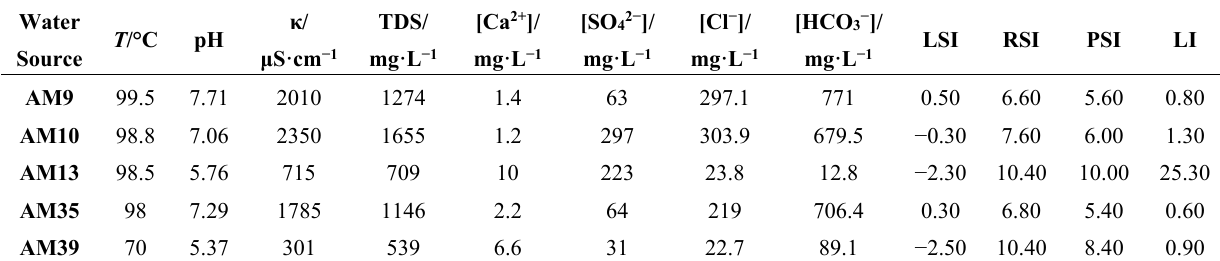
Table 1. Temperature, pH, conductivity ( κ ), total dissolved solids (TDS) and major element composition of mineral water from boiling pool (bp) discharges in the Azores archipelago according to Cruz et al. [16]. Calculation of the corresponding stability and scaling indexes, namely the Langelier Saturation Index (LSI), Ryznar Stability Index (RSI), Puckorius Scaling Index (PSI) and the Larson–Skold Index (LI).